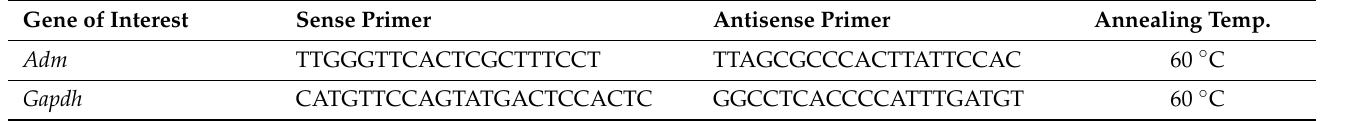
Table 1. Primers used for quantitative real-time